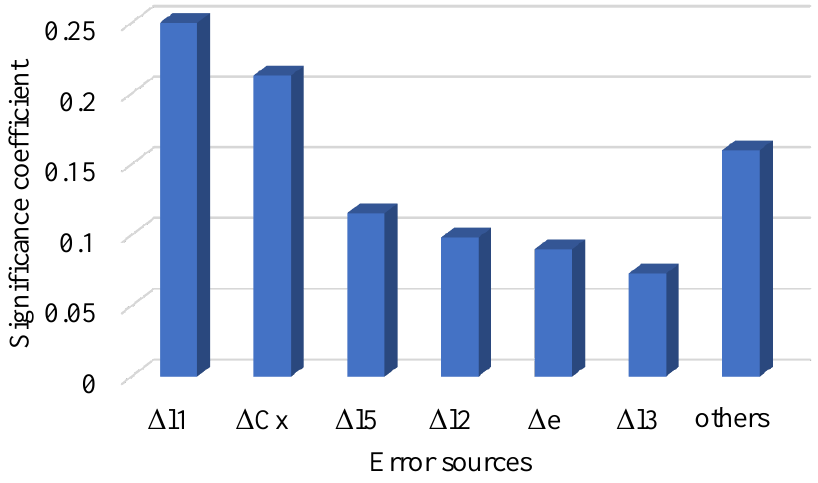
Figure 7. Significance coefficient on the inclined angle error of the slider.